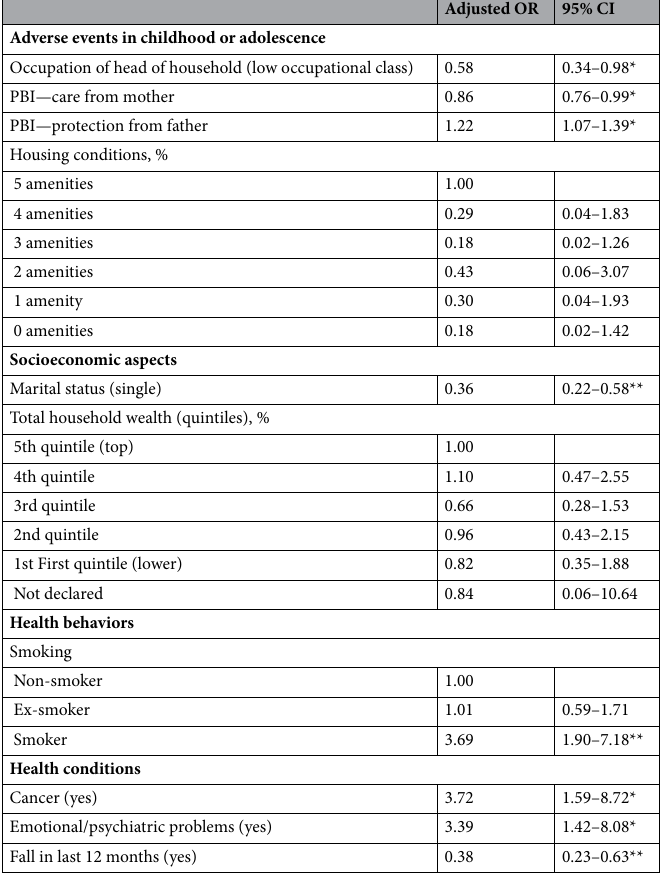
Table 4. Final model of factors associated with death before the age of 80 among women (n = 445) aged 50 years or older at baseline of ELSA study (2006) in 12-year follow-up period. OR odds ratio, CI confidence interval; adjusted for current income and housing conditions in childhood. * p < 0.05; ** p <